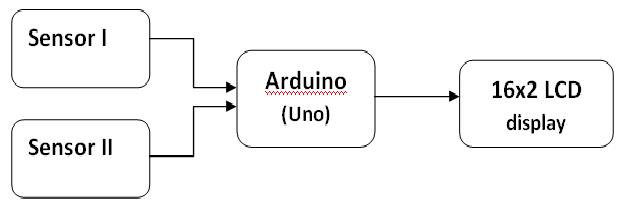
Fig. 2. Block diagram of the proposed